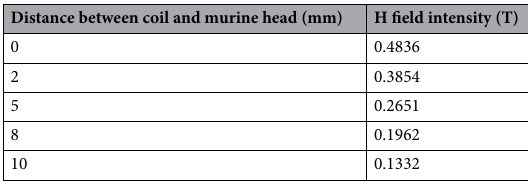
Table 3. Magnetic field intensity summary.